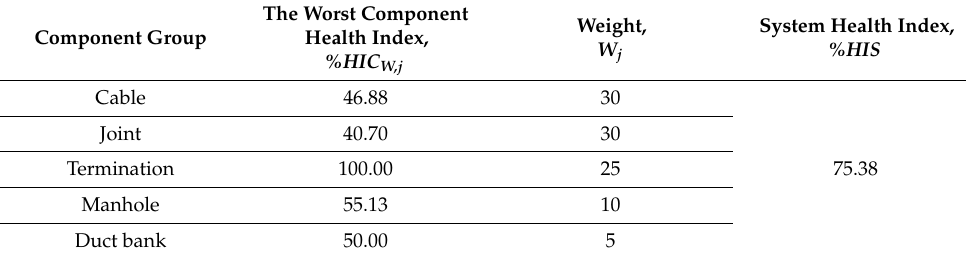
Table 4. Calculation of cable system health index of feeder F-01.